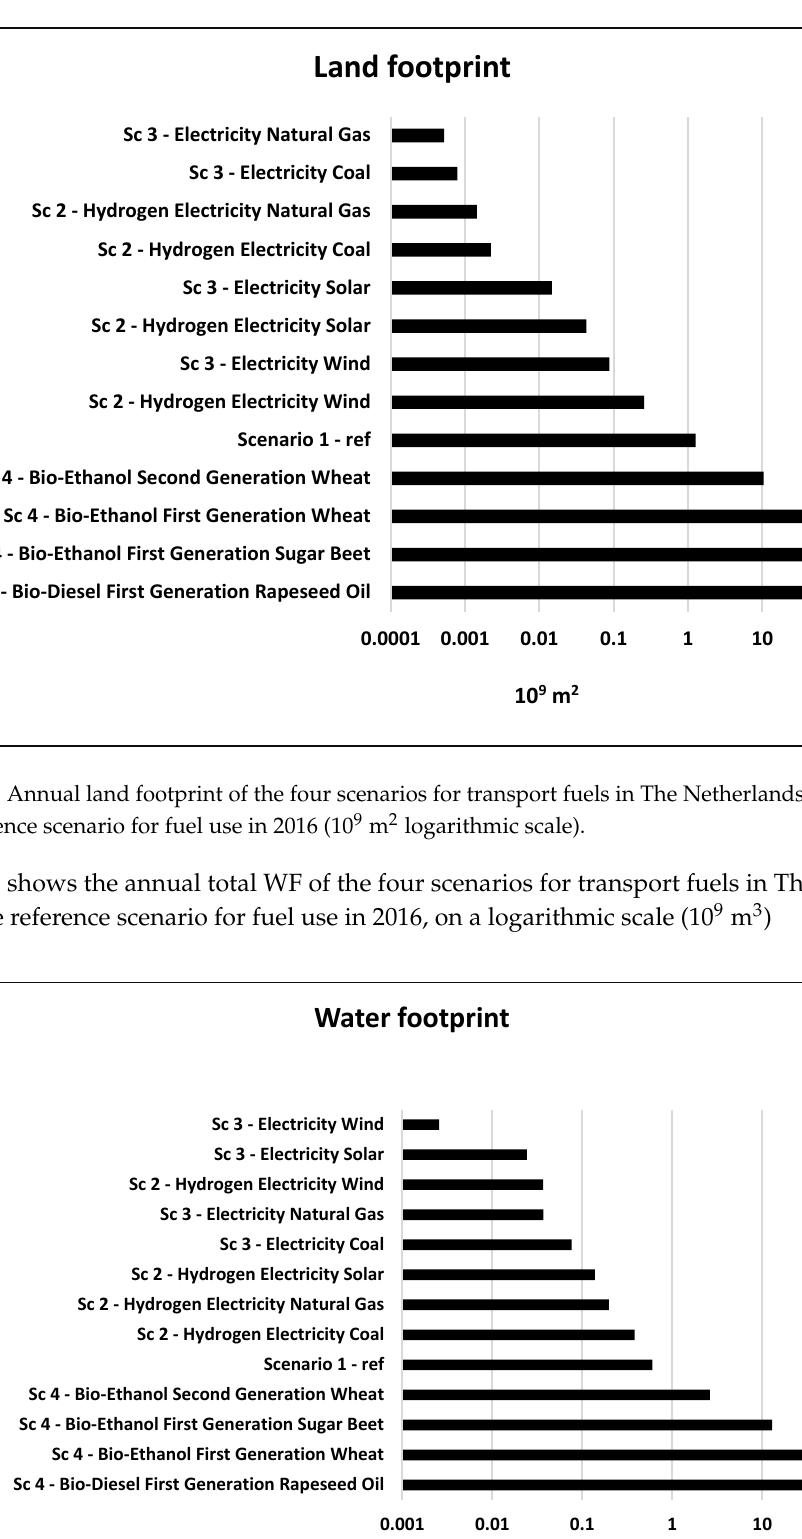
Figure 7. Annual carbon footprint of the four scenarios for transport fuels in the Netherlands, including the reference scenario for fuel use in 2016 (Mt CO 2 e).